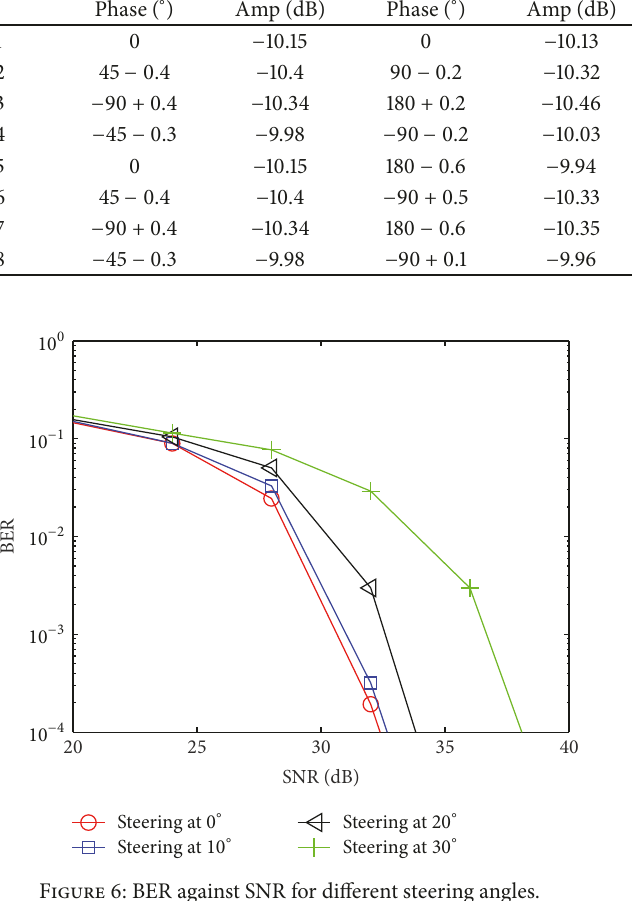
Figure 6: BER against SNR for different steering